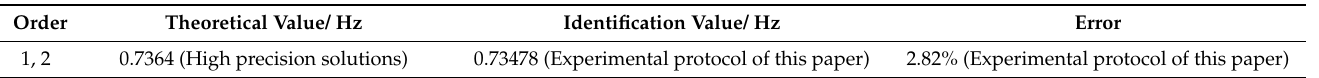
Figure 14. Measurement error of this experimental vision scheme.